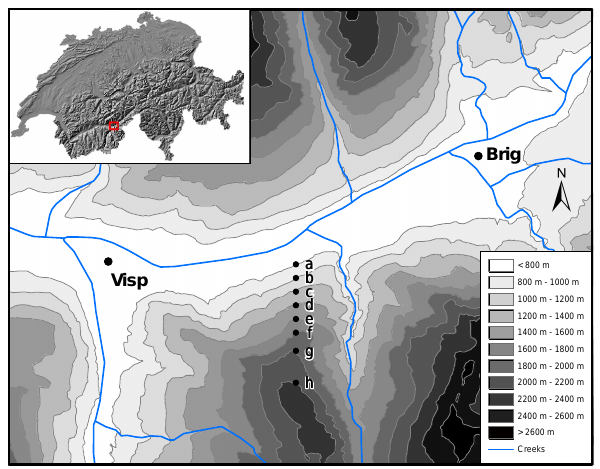
Fig. 3. Terrain around and location of the modeled stands (a) – (h) . See Table 2 for detailed values of the stands’ altitude.